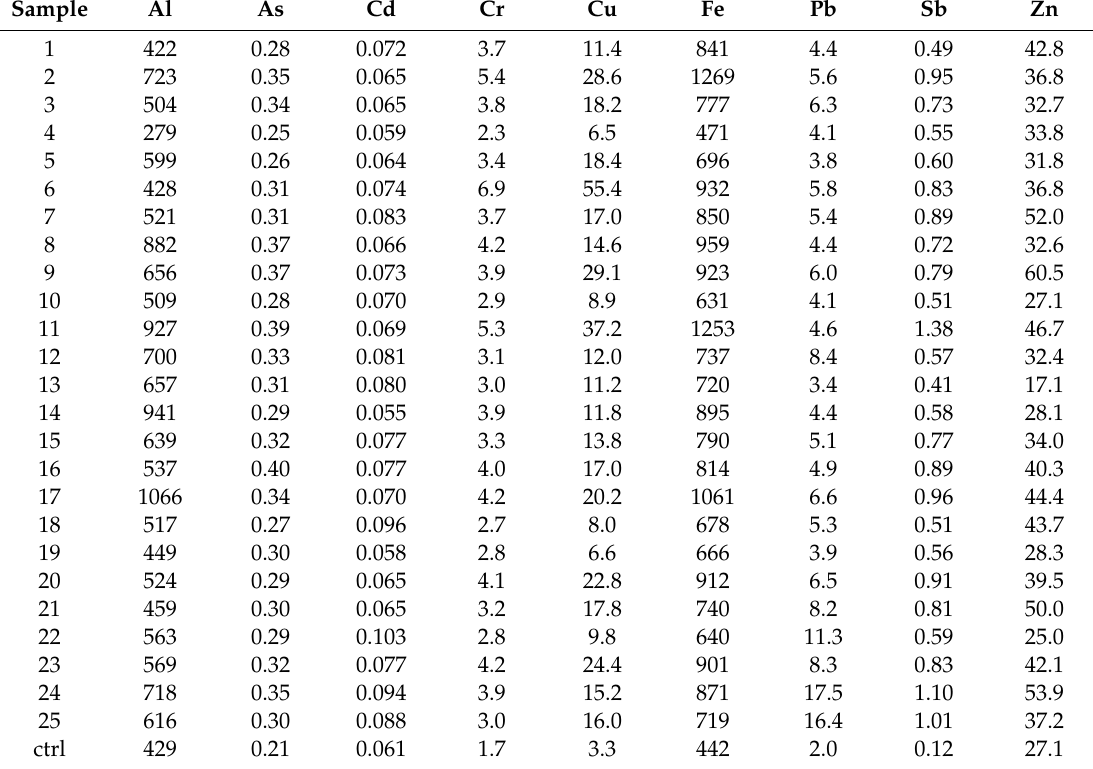
Table 1. Concentrations ( µ g / g dw) of trace elements in samples of the lichen Evernia prunastri exposed for 3 months at 25 sites in Milan, as well as at a control site